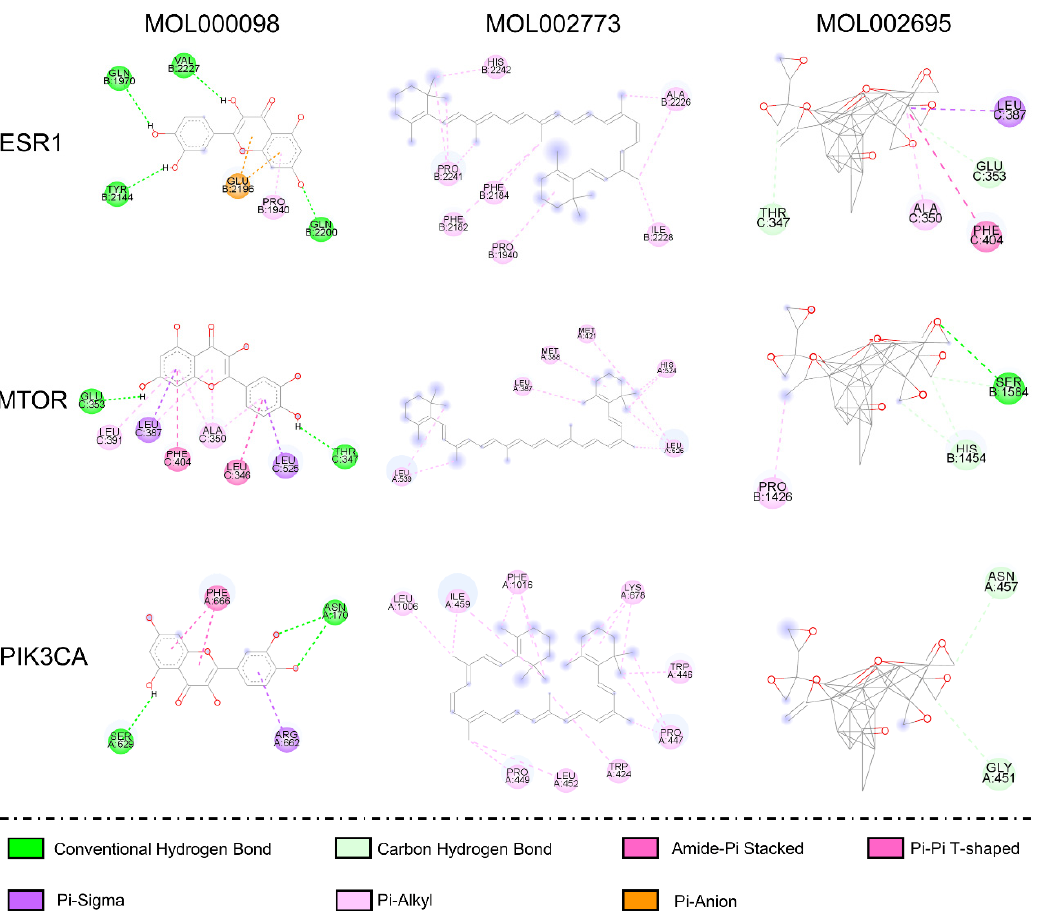
Figure 9. The binding energy between key components and targets visualized by heat map.